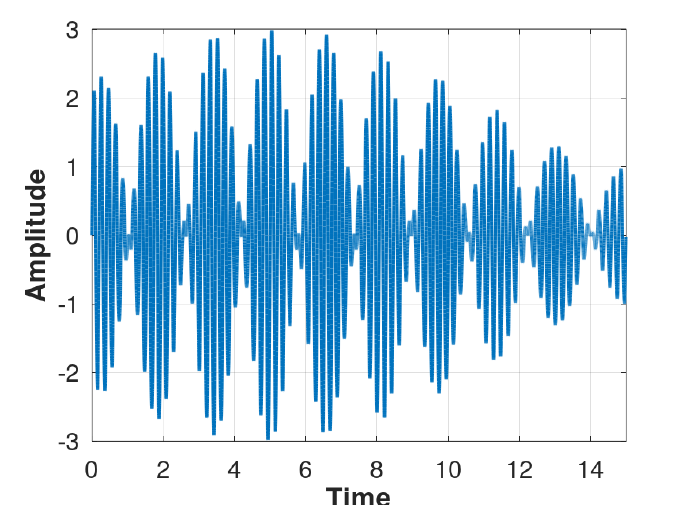
Figure 4. Parkinson’s tremor signal in the time